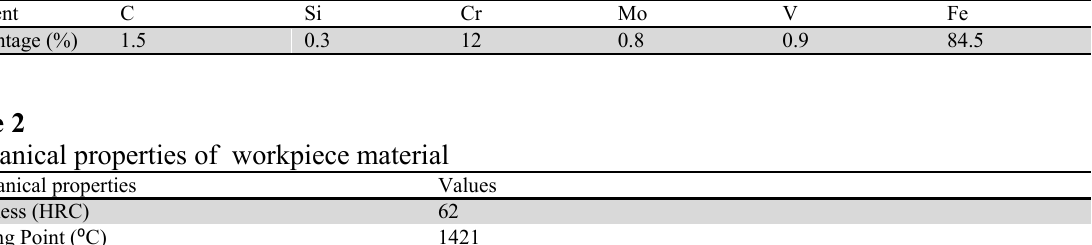
Chemical composition of D 2 steel